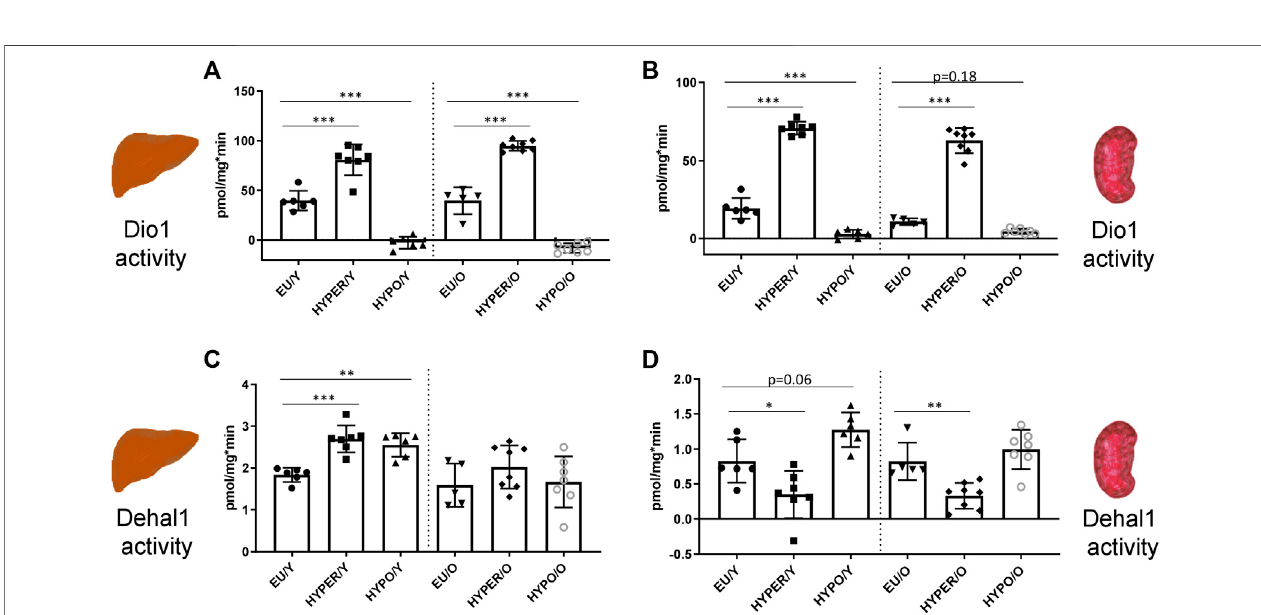
FIGURE 2 | Deiodinating enzyme activities in liver and kidney; Dio1 activity is regulated in parallel in liver (A) and kidney (B) by HYPO and HYPER treatment. In contrast to thyroidal activity, in both organs Dio1 activity is strongly stimulated in HYPER animals and reduced in HYPO mice, independent of age. Dehal1 activity is just slightlychangedintheseorgans,showingaslightbutstillsigni fi cantinductioninHYPERandHYPOgroupsintheliver (C) ,exclusivelyinyounganimals.Inthekidney (D) , HYPOtreatmentleadstoreducedactivitylevelsinboth,youngandagedmice[younggroups(Y)ontheleft,oldgroupsontheright(O)].Allmeasurementsusedthe Sandell-Kolthoff-reaction as readout. Signi fi cance is tested by ANOVA test followed by Bonferroni ’ s test. ( n = 5 – 8/group); * p ≤ 0.05, ** p ≤ 0.01, *** p ≤ 0.001.